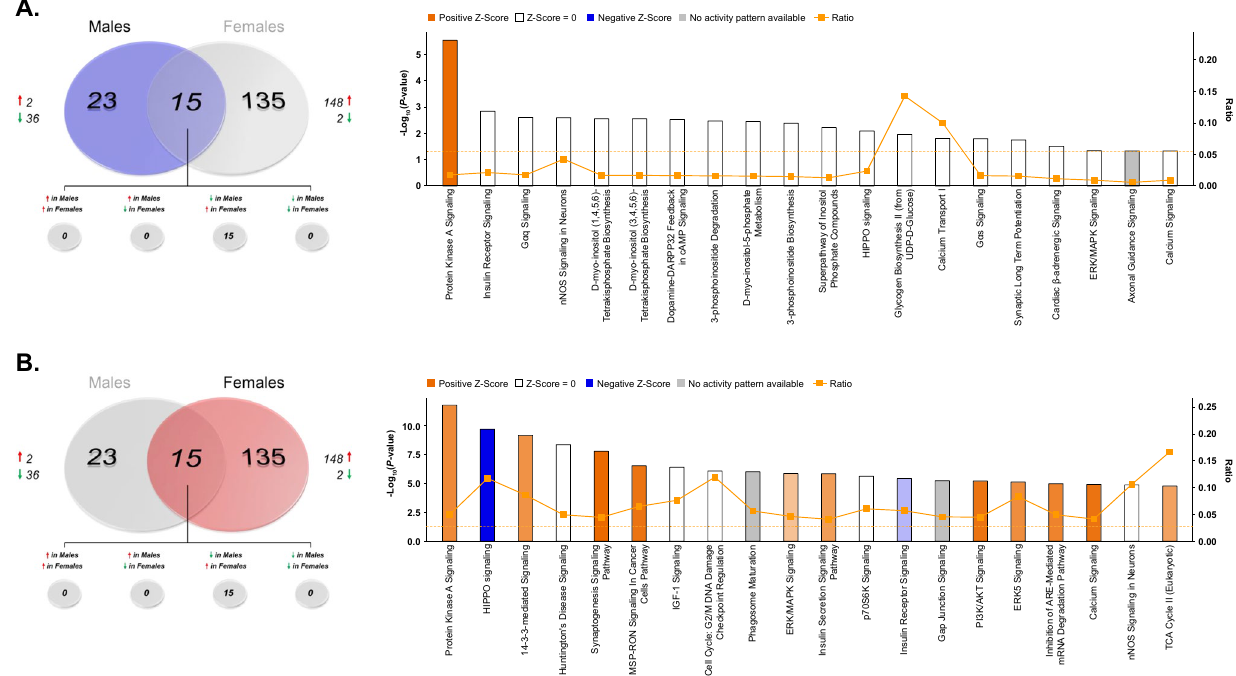
Figure 9. IPA enrichment analyses of ketamine-induced changes in protein phosphorylation in the dHPC of male and female rats. ( A , B ) Canonical pathway enrichment for phosphoproteins significantly differentially abundant in ketamine vs. saline-treated male ( A ) and female ( B ) rats 30 min following treatment. Based upon the direction of fold change of significant differentially abundant phosphoproteins within the dataset, the Z -Score serves as a predictor of pathway activation states by assessing the match between the observed and predicted (evidence-based) up/down regulation patterns 41 . Pathways are colored by predicted activation state: orange (activated) or blue (inhibited), where darker colors represent higher absolute Z -scores. Z-scores for pathways colored in gray could not be calculated due to insufficient evidence for a prediction of either activation or inhibition to be made. The ratio (solid orange line) represents the number of molecules within the comparison dataset meeting the cutoff criterion ( p < 0.05; Fisher’s Exact Test), divided by the number of molecules comprising a given pathway within the reference set (Ingenuity Knowledge Base). Bar graphs were produced in Ingenuity Pathway Analysis (IPA) software (QIAGEN, Given the lack of knowledge regarding signaling mechanisms mediating the enhanced behavioral sensitivity of female rats to low-dose ketamine compared to males 26,62 , phosphoproteins differentially-abundant between ketamine- and saline-treated female rats were submitted to IPA for canonical pathway enrichment analysis in order to compare ketamine-induced signaling pathway activation between sexes. This analysis yielded a surpris- ing parallel in the pathway exhibiting the greatest statistical enrichment of ketamine-affected phosphoproteins in both males (Fig. 9A; Supplemental Table S25) and females (Fig. 9B; Supplemental Table S26)—PKA signal- ing. Of course, the primary difference exhibited between sexes was the direction of ketamine-induced change in phosphoprotein abundance. Whereas ketamine significantly reduced levels of phosphoproteins within this pathway, nearly all of those observed in females were greatly elevated when compared to saline-treated controls. Synaptogenesis signaling was also selectively enriched in ketamine-treated females; however, this is not surprising